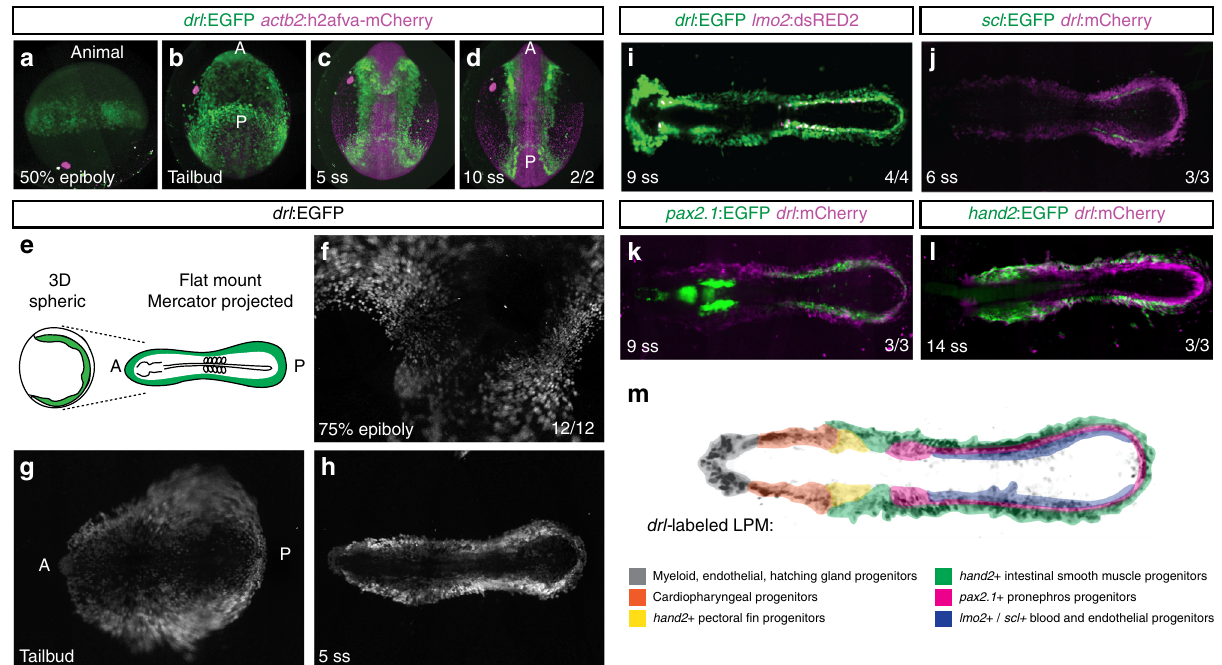
Fig. 1 The LPM forms as a continuous fi eld around the circumference of the developing zebra fi sh embryo. a – d Panoramic SPIM imaging of 50% epiboly to 10 ss embryos transgenic for drl : EGFP (green) and actb2:h2afva-mCherry (magenta); maximum-intensity-projected, lateral view ( a ), dorso-ventral views (anterior (A) to the top, posterior (P) bottom) ( n = 2/2) ( b – d ). e – h Representative panoramic SPIM imaged drl:EGFP zebra fi sh embryo shown as 2D Mercator projection ( n = 12/12). e Schematic of Mercator projection of spherical embryo, anterior to the left; f – h Mercator projections at 75% epiboly, tailbud, and 5 ss stages. i – l Single time point projections (anterior to the left) of representative double-transgenic embryos for drl reporters and ( i ) lmo2 ( n = 4/4), ( j ) scl ( n = 3/3), ( k ) pax2.1 ( n = 3/3), or ( l ) hand2 ( n = 3/3) reporters co-expressed in dedicated LPM territories. m Summary schematic